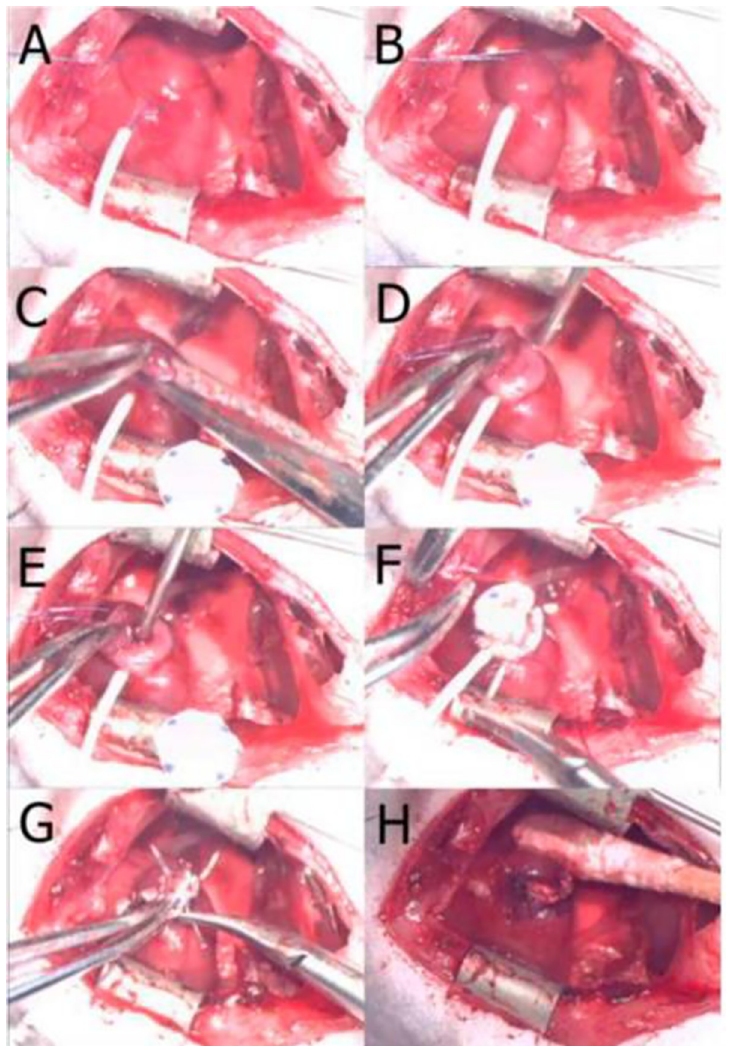
Fig 2. Various stages of patch implantation. (A): A purse string suture placement in the left ventricle apex wall; (B): tourniquet tightening; (C): cutting the distended part of the left ventricle apex wall; (D) flap creation; (E): needle used to examine hole creation; (F): cardiac patch implantation; (G): closing the flap (H): purse string suture removal.